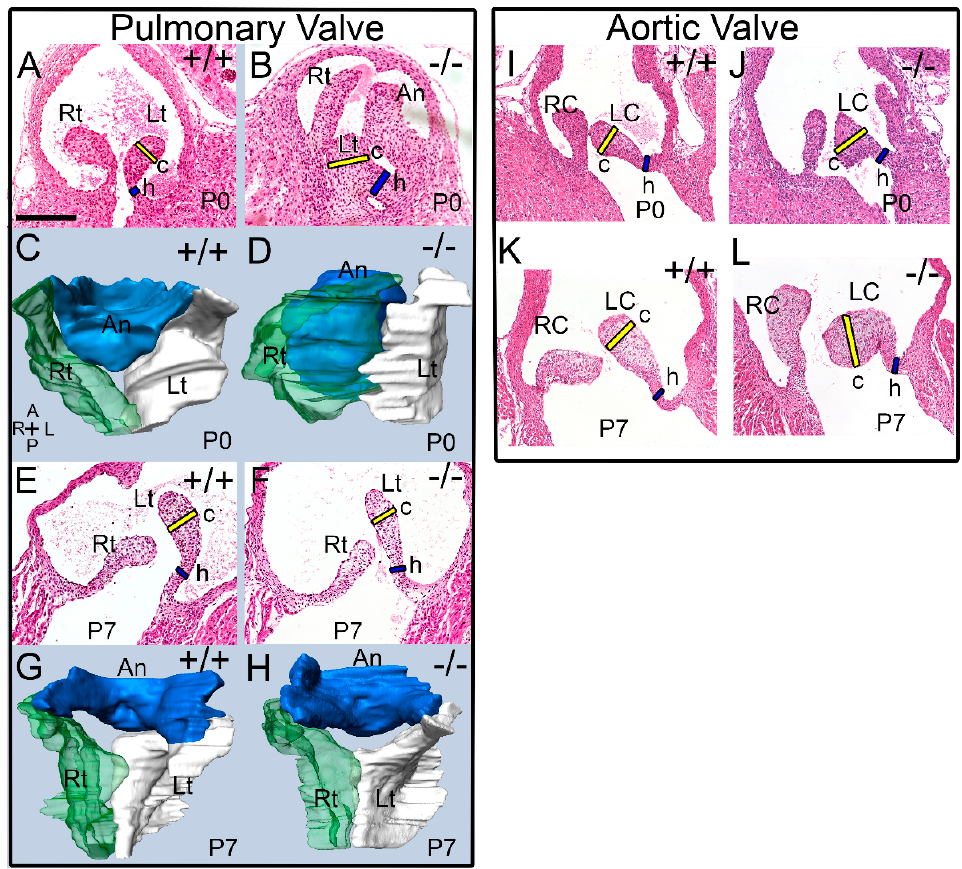
Figure 1. Three-dimensional reconstructions and histological sections revealed that the abnormal enlarged morphology of the Adamts5 − / − pulmonary valves at birth was transiently corrected at postnatal day 7. Histological sections ( A , B , E , F ) and three-dimensional (3D) reconstructions ( C , D , G , H ) indicate the morphological correction of the Adamts5 − / − pulmonary valve (PV). Hematoxylin and Eosin-stained ( H & E ) sections show the normal morphology of the wild type (+/+; A ) PV compared to the Adamts5 − / − PV ( − / − ; B ) at postnatal day 0 (P0). 3D reconstructions at P0 revealed the enlarged, block-like shape of the Adamts5 − / − PV ( D ). Rt—right cusp of the PV, Lt—left cusp of the PV, An—anterior cusp of the PV; RC—right coronary cusp of the aortic valve (AV), LC—left coronary cusp of the AV. At postnatal day 7, (P7) the normal sculpted morphology of the PV cusps of +/+ and − / − PV ( E , F ) at P7 was evident in the 3D reconstructions ( G , H ; Blue—An PV cusp, Green—Rt PV cusp, and White—Lt PV cusp). Black bar in A = 150 μ m and applies to ( B – L ). Orientation to 3D reconstructions ( C ): A—Anterior, P—Posterior, R—Right, L—left. Blue bars on each ( H & E ) section indicates hinge region measurement; yellow bars indicate the area of the cusp that were measured, related data is in Figure 2. Histological sections and 3D reconstructions were representative of each genotype and timepoint.